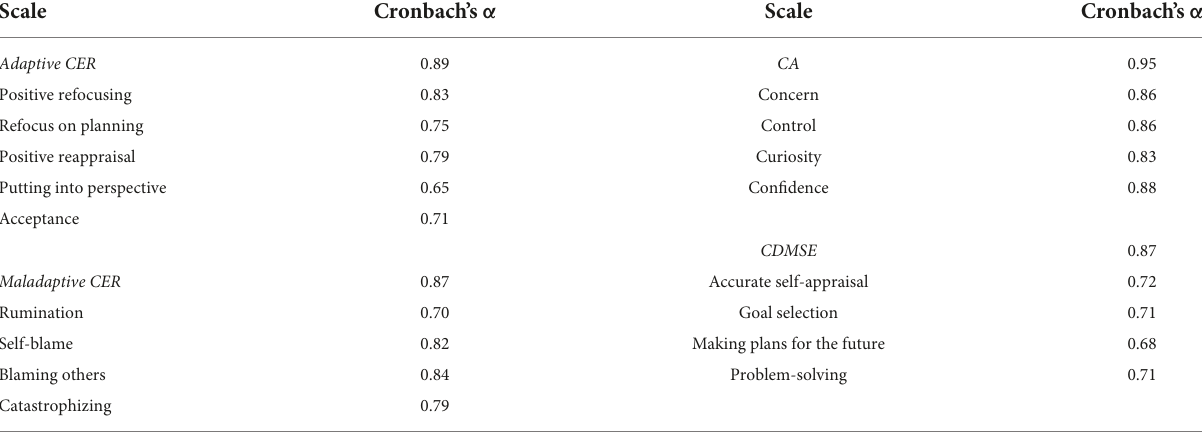
TABLE 3 Internal consistency reliability coefficients of the